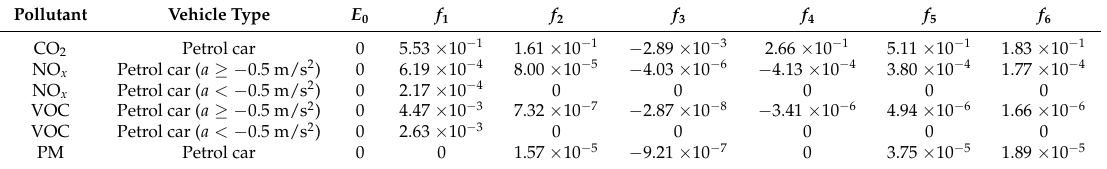
Table 2. Emission functions values; a is the acceleration of a vehicle; selected and reproduced from